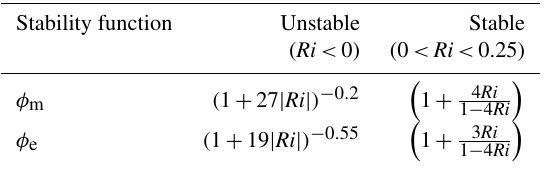
Table 3. Stability functions for unstable and stable regimes from Cullen (2003). Stability function Unstable